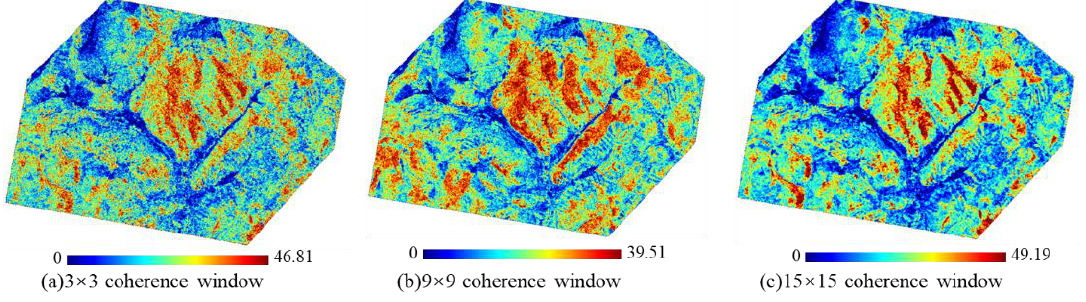
Figure 5. Forest height accuracy verification with different coherence estimation methods